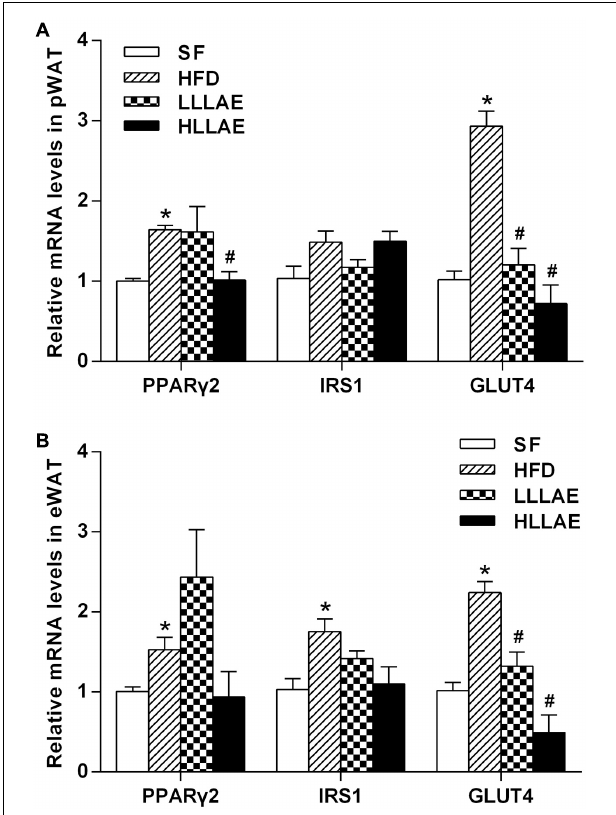
FIGURE 6 | Effects of LLAE on the expression of PPAR γ 2, IRS1, and GLUT4 in pWAT (A) and eWAT (B) of HFD-induced obese rats. HFD-induced obese rats were administrated with low dose LLAE [0.5 g crude drug/(kg.d), LLLAE] or high dose LLAE [3.0 g crude drug/(kg.d), HLLAE] for 6 weeks by gavages. Then perirenal white adipose tissue (pWAT) and epididymal white adipose tissue (eWAT) were taken. The total RNA of adipose tissue was extracted and then RT-qPCR was performed as described in Section “Materials and Methods.” The data represent the mean ± SD. ∗ P < 0.05 vs. SF group; # P < 0.05 vs. HFD